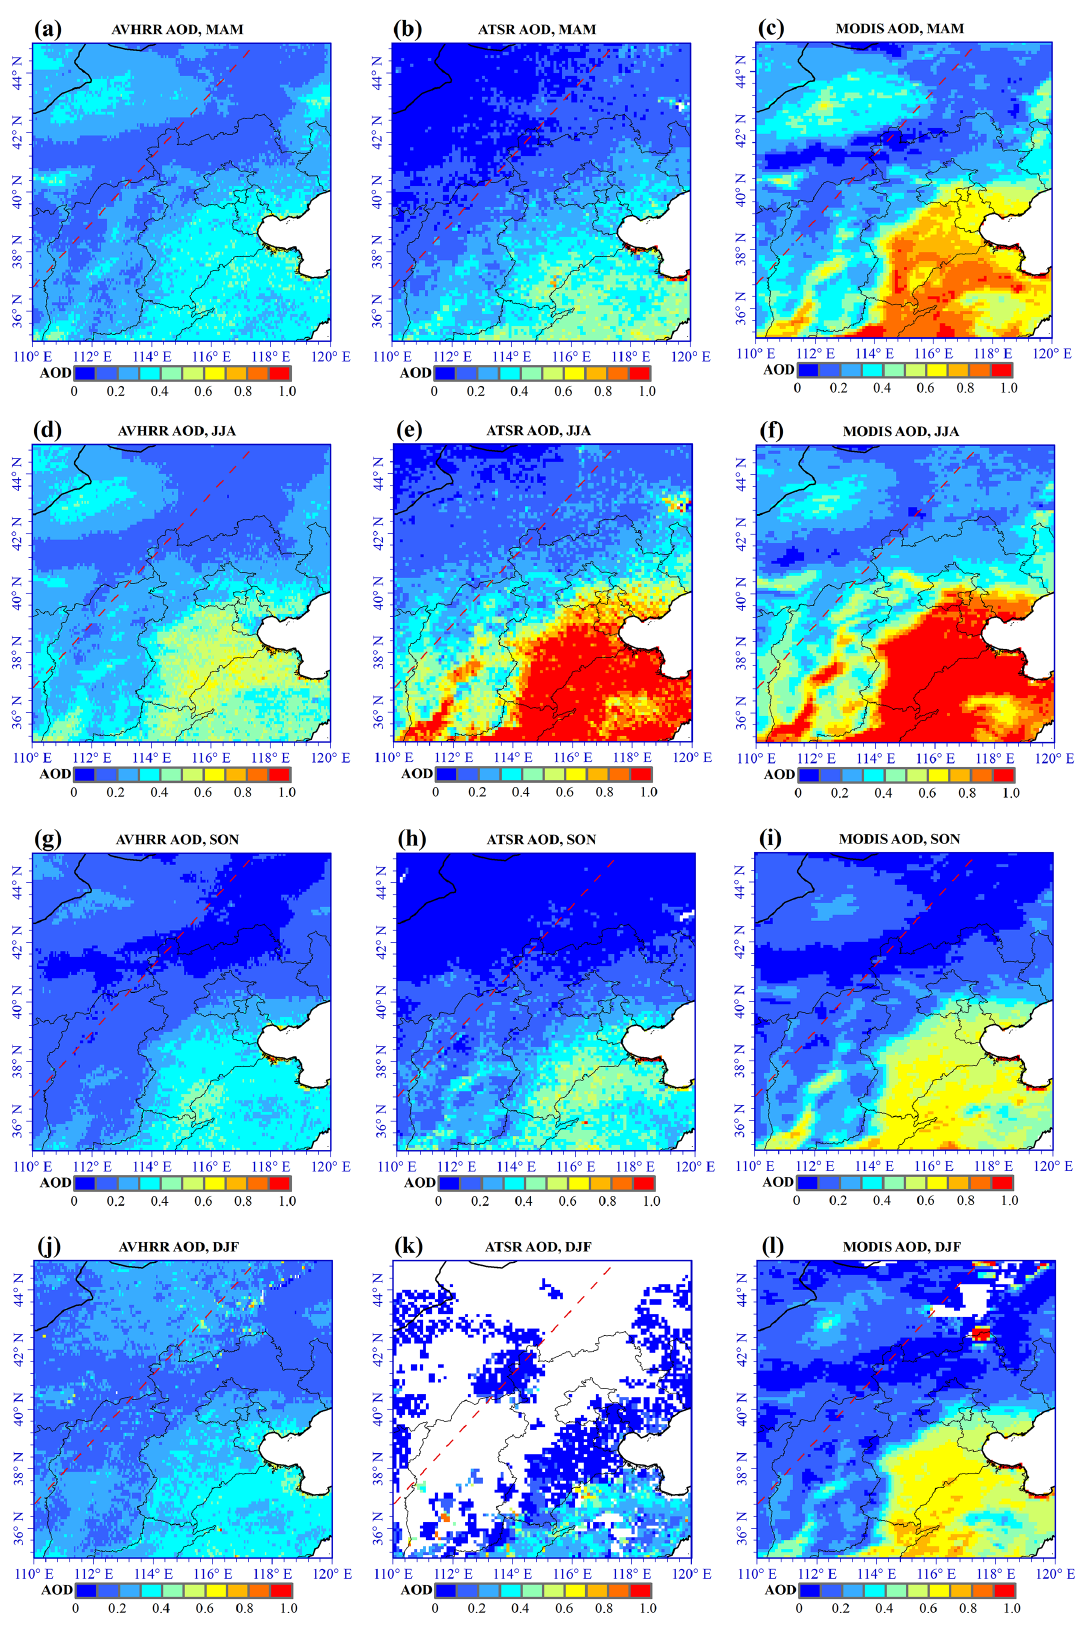
Figure 2. AOD over the study area retrieved from AATSR (ADV version 2.31, L2, 10 × 10km 2 ), AVHRR (ADL, 0 . 05 ◦ × 0 . 05 ◦ ) and MODIS C6.1 merged DBDT (MODIS C6.1, L2, 10 × 10km 2 ). All have data been seasonally aggregated over the years